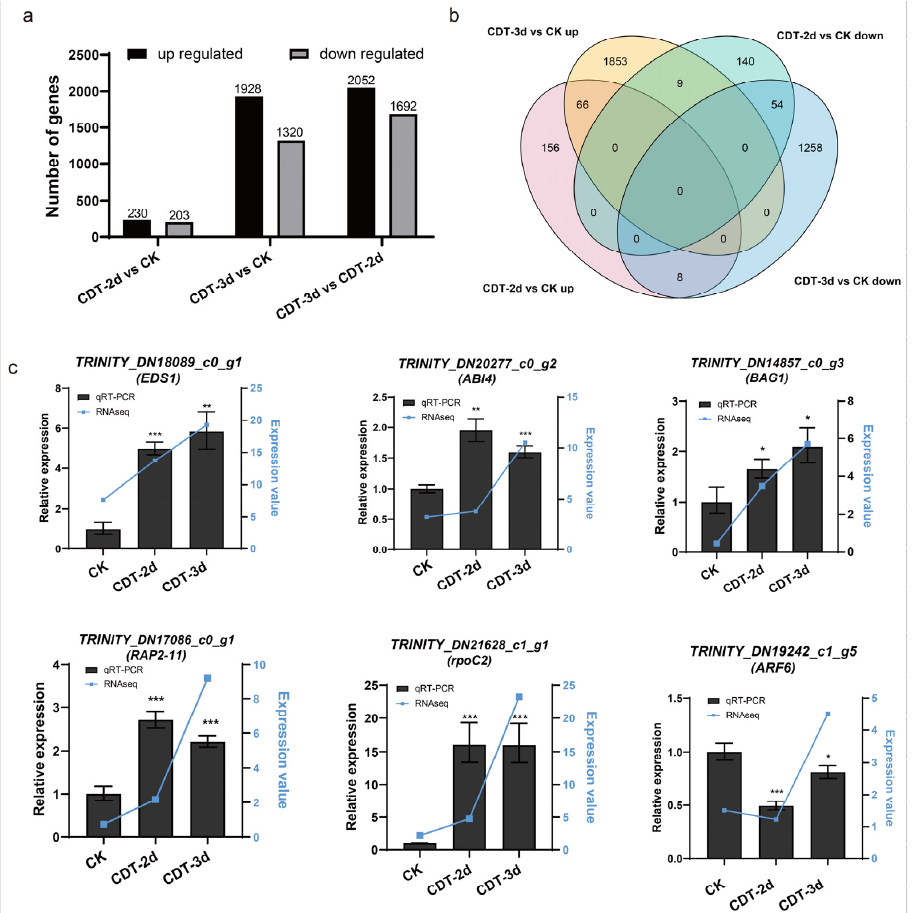
Figure 3. Differentially expressed genes (DEGs) during seed aging in transcriptome and expression verification by qRT − PCR. CK, control check; CDT − 2d, seeds aged for two days; CDT − 3d, seeds aged for three days. ( a ) The bar chart shows the number of up − regulated and down − regulated DEGs in comparison to the three libraries, with FDR ≤ 0.05, and|log 2 FC| ≥ 1 as the threshold. ( b ) Venn diagrams show the number of genes up and down − regulated during the aging of elm seeds. ( c ) The comparison of qRT − PCR and sequencing results of six genes. The actin of elm was used as an internal reference. All reactions were repeated three times. Error bars indicate the standard de- viation of three replicates. *, p < 0.05; **, p < 0.01; ***, p < 0.001. The expression data by transcriptome sequencing are shown by the broken blue line for the sake of comparison.